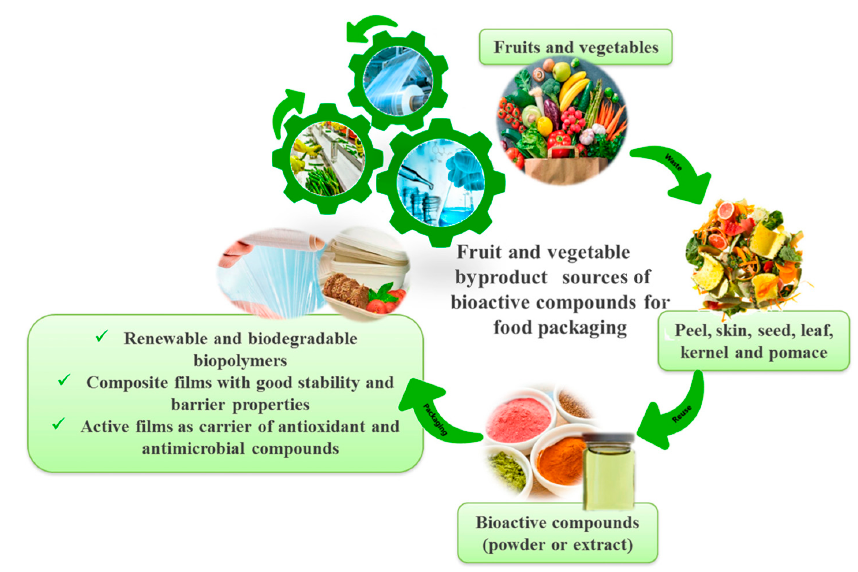
Figure 2. Potential application of agro-waste products in packaging [27].